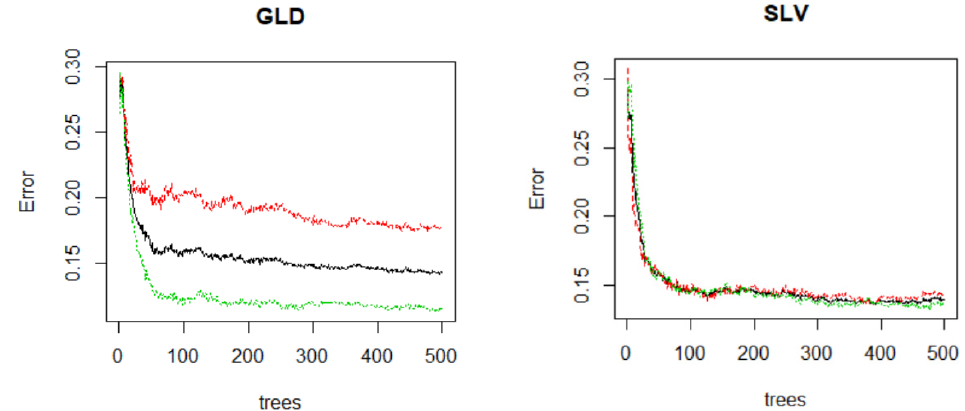
Figure 3. This figure shows RFs test error vs. the number of trees. OOB (Red), down classification (Black), up classification (Green). Calculations are done for predicting stock price direction over a 10-step forecast horizon.